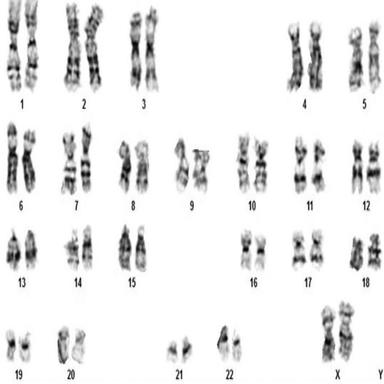
Representative karyogram from NC expanded according to modified process of a female patient. Expansion was performed until passage 4 (corresponding to a total of 18.1 PDs).